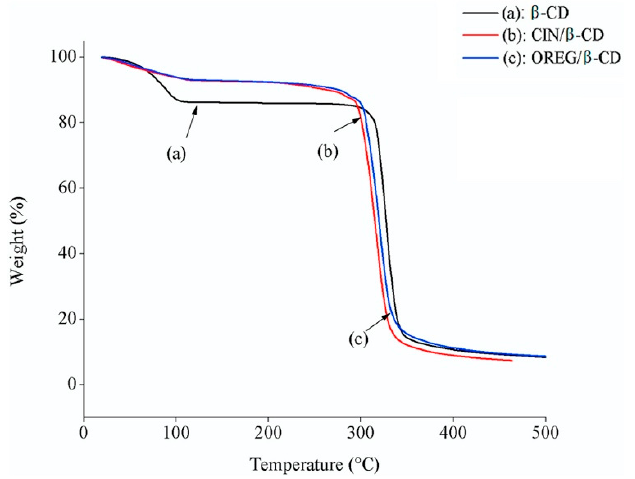
Figure 22. TGA curves of ( a ) plain β‐ cyclodextrin ( β‐ CD), ( b ) microencapsulated cinnamon (CIN/ β‐ CD), and ( c ) oregano (OREG/ β‐ CD) [205].